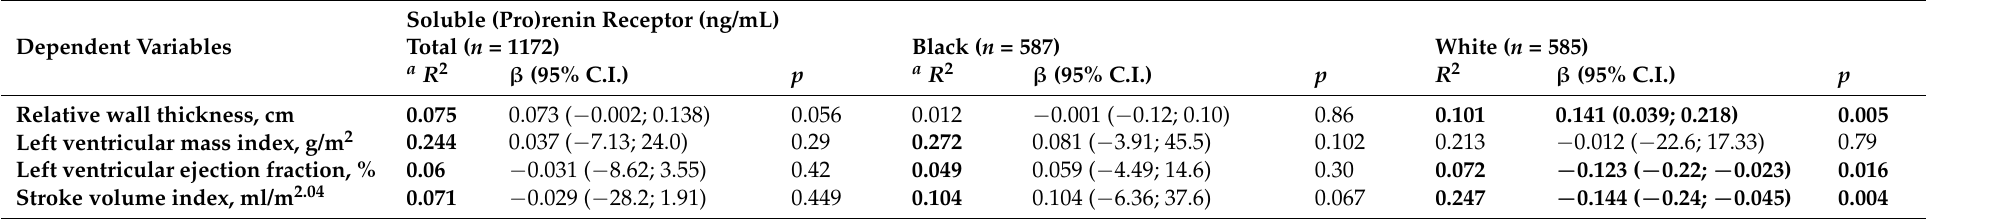
Table 4. Associations between left ventricular structure and function and soluble (pro)renin